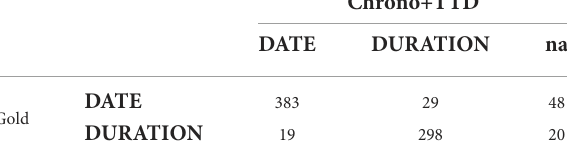
TABLE 4 Confusion matrix for Chrono+TTD (ClinBioBert-Seq2Seq-Ttype) using the RelIV-TIMEX Evaluation data set.